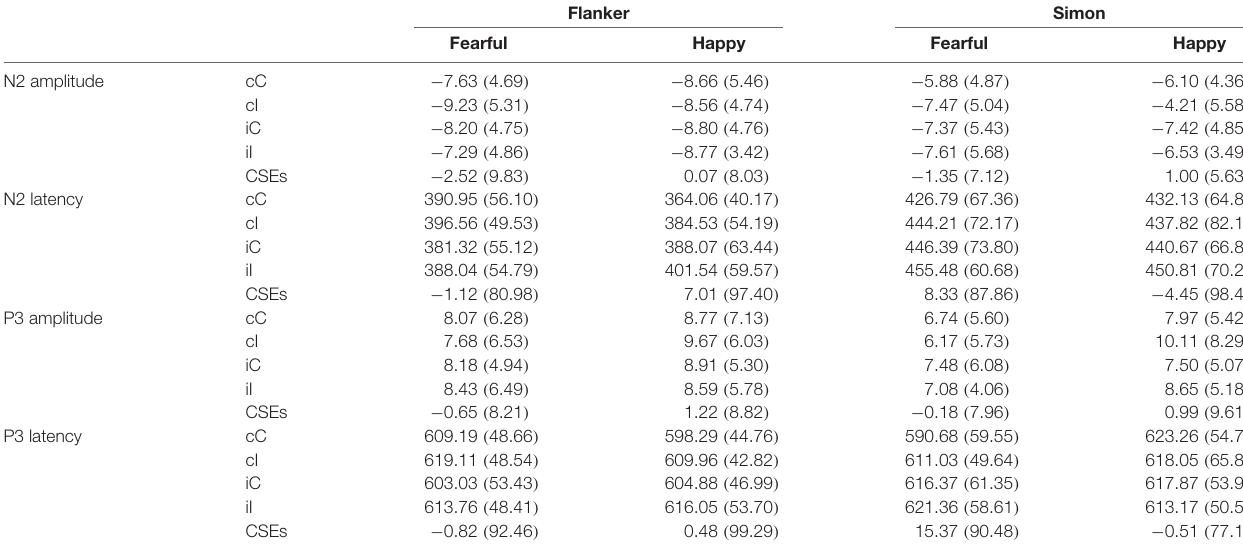
TABLE 3 | The mean amplitudes and peak latencies of N2 and P3 and the magnitude of emotional CSEs in 5-year-old children. Flanker Simon